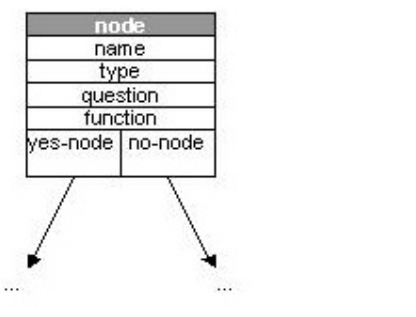
Fig. 6. Building block element for the decision tree used for function annotation in MyBSML Studio